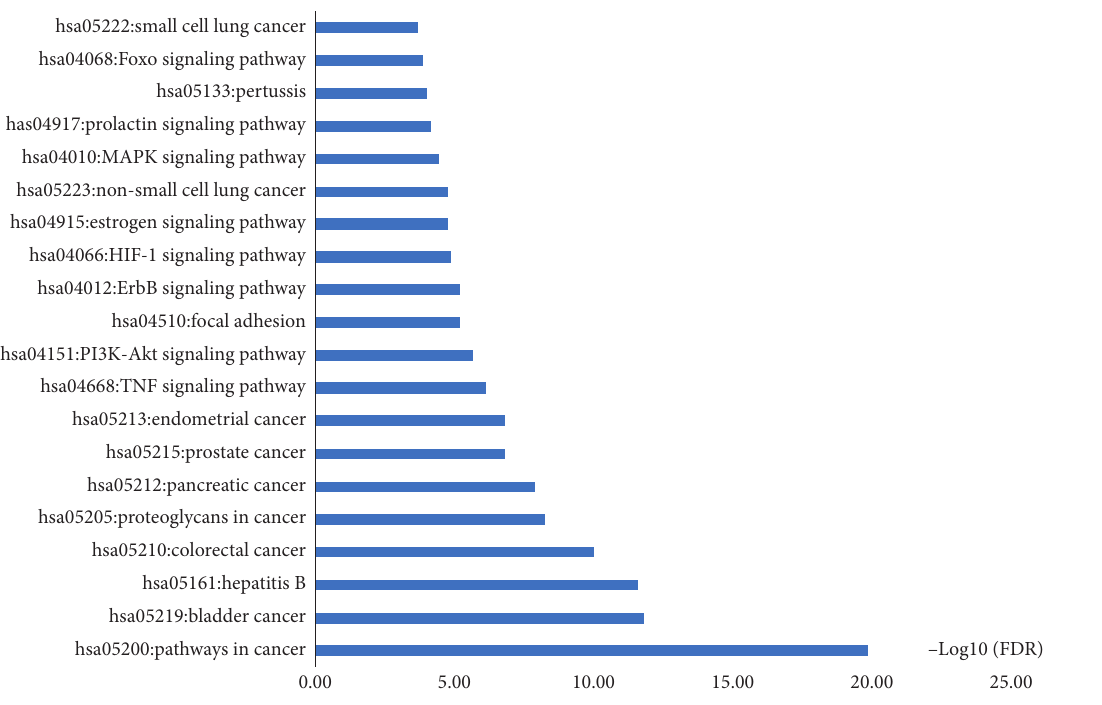
Figure 4: KEGG pathway